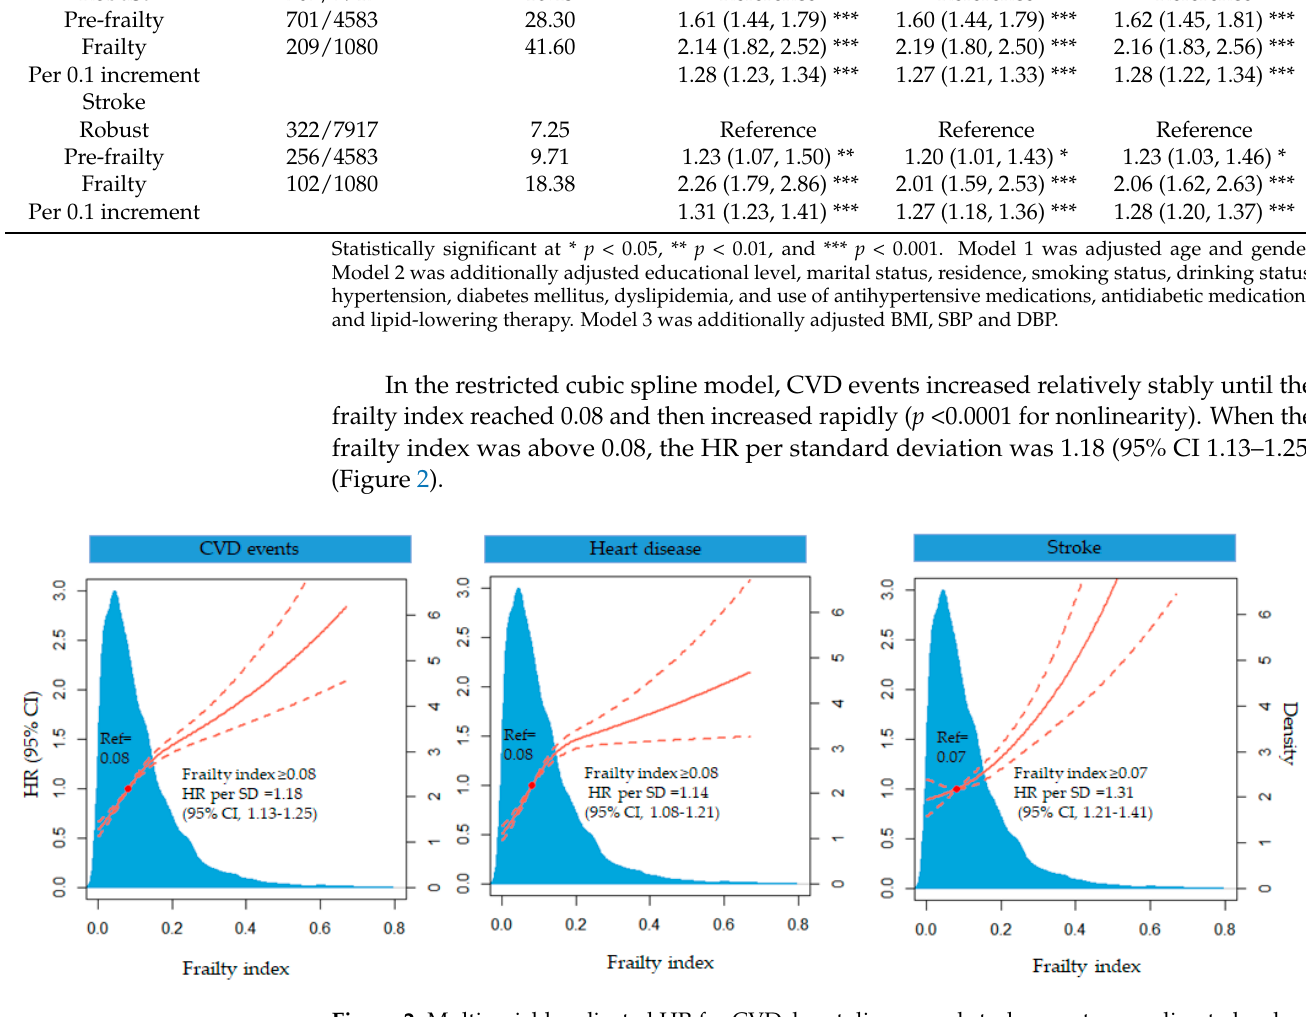
Figure 2. Multivariable-adjusted HR for CVD, heart disease and stroke events according to levels of frailty index. The solid red line is the multivariate adjusted hazard ratios, and the dashed red line is the 95% CI from a restricted cubic spline model with three knots at the 10th, 50th and 90th centiles. Model was adjusted for age, gender, educational level, marital status, residence, smoking status, drinking status, hypertension, diabetes mellitus, dyslipidemia, use of antihypertensive medications, antidiabetic medications and lipid-lowering therapy, BMI, SBP and DBP.